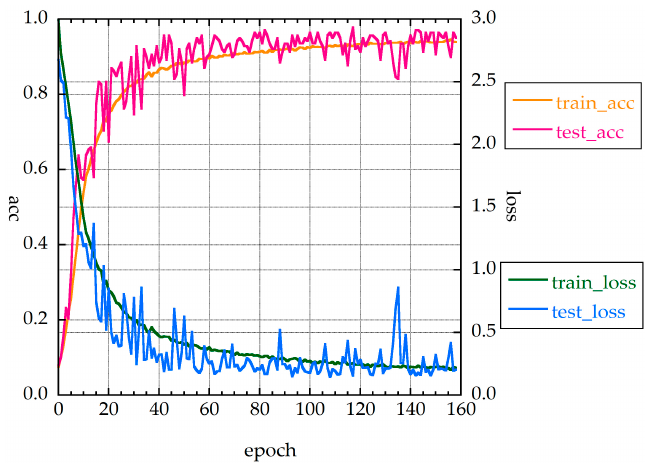
Figure 5. Accuracies and loss function values of MLP_M for 30 measurements without HQ.